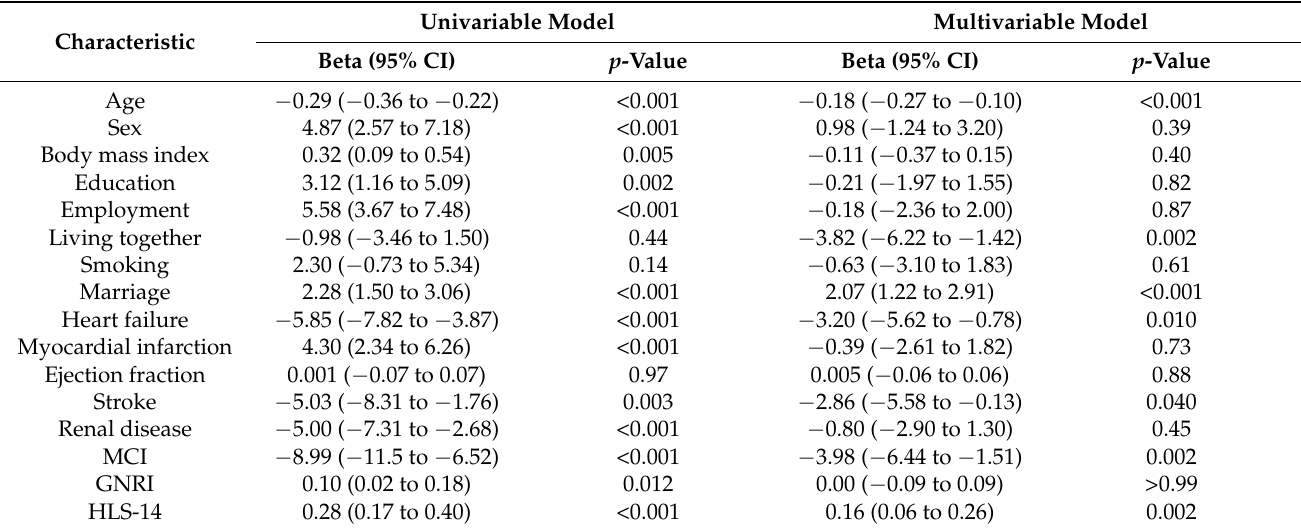
Table 2. Multiple linear regression test for the total score of the Functional Independence